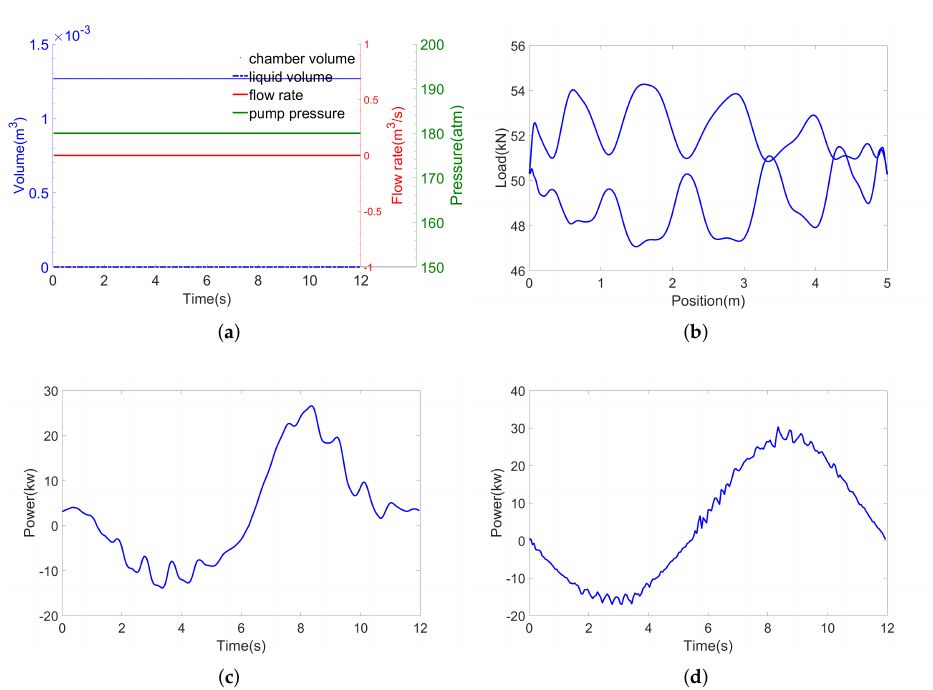
Figure 11. Parting rod working state. ( a ) Pump simulation. ( b ) Generated DC. ( c ) Generated MPC. ( d ) Actual